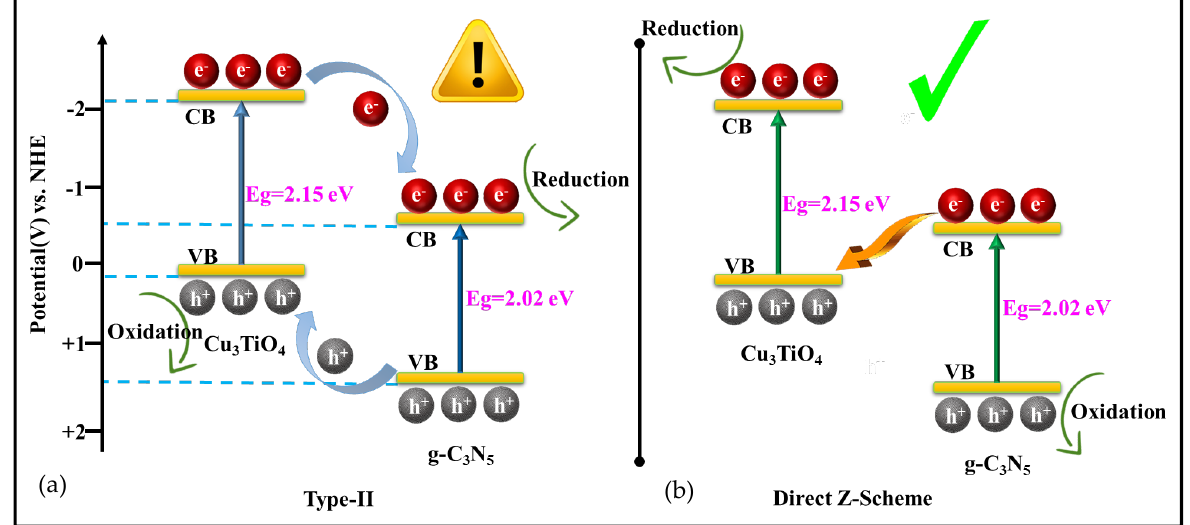
Figure 7. Proposed electron-hole pair transfer mechanism of g-C 3 N 5 /Cu 3 TiO 4 nanocomposite ( a ) type-II, ( b ) Direct Z-Scheme.